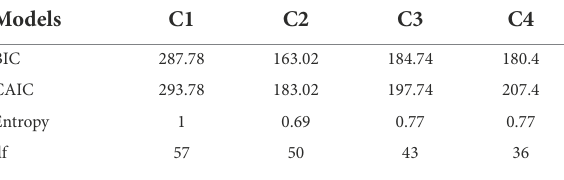
TABLE 2 Model fit indices and degree of freedoms under models with different numbers of groups. Models